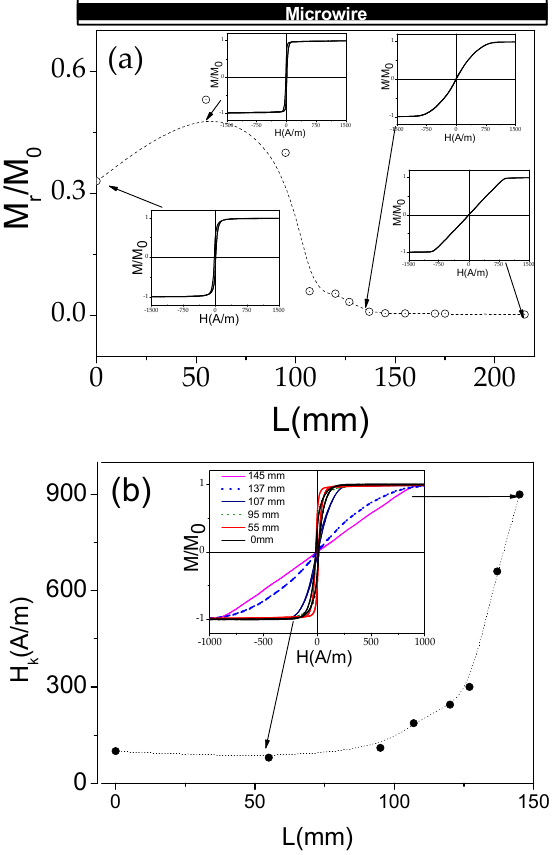
Figure 7. Variation of M r /M 0 ( a ) and H k ( b ) in sample 1 annealed at variable T ann . The lines are just guides for the eyes.